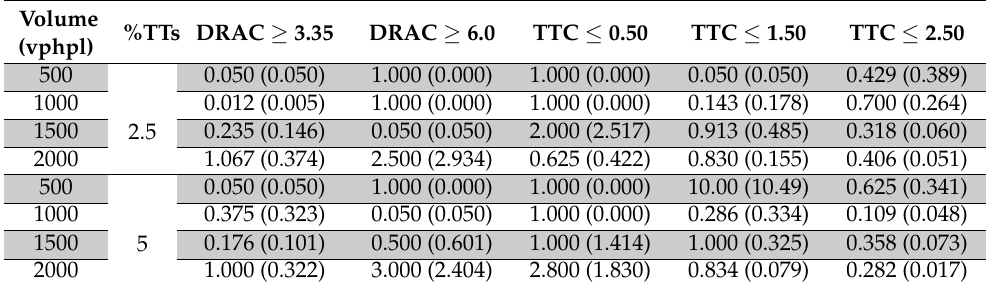
Table 5. Conflict ratio between TT speed of 60 km/h before and TT speed of 70 km/h after for PC speed limit of 90